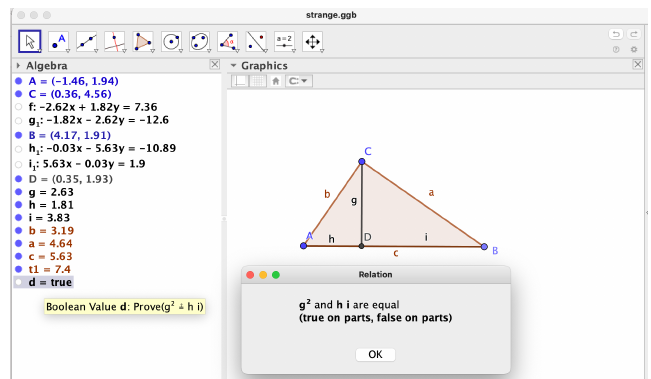
Figure 7. Two different outputs (Boolean Value d = true , or “true on parts, false on parts”) for the thesis of the Altitude Theorem over a right triangle, when the Prove , respectively, the Relation commands are